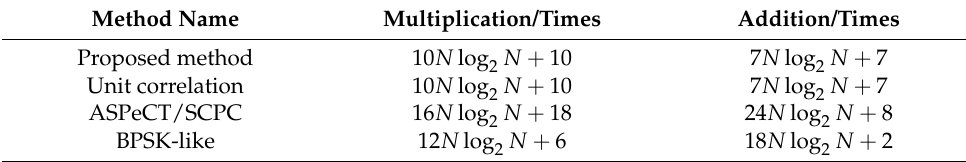
Table 1. The calculation burden between different